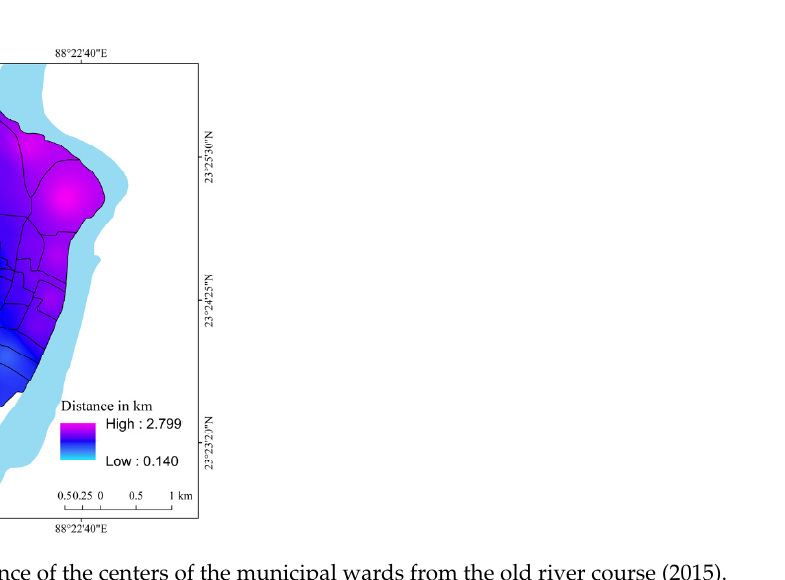
Figure 40. NDTI (2015).